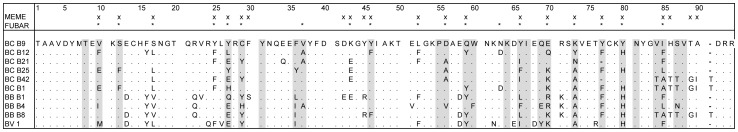
Amino acid alignment of a subset of MHC class II sequences.MHC class II amino acid sequences of B. calamita (BC), B. bufo (BB) and B. viridis (BV). Position 2 is the first amino acid position in exon 2 in these species according to splice site analysis. Position 5 corresponds to the first amino acid position of the second exon in the human MHC locus HLA-DRB. Shaded columns represent putative antigen binding sites (ABS) according to Brown et al. (1993) and/or Tong et al. (2006). Sign ‘−’ at position 77 denotes a codon deletion; signs ‘x’ and ‘*’ indicate amino acid positions under positive selection as determined by a mixed effects model of evolution (MEME) and a fast unbiased Bayesian approximation (FUBAR), respectively. The positive selection analysis was based on 57 alleles from locus B.